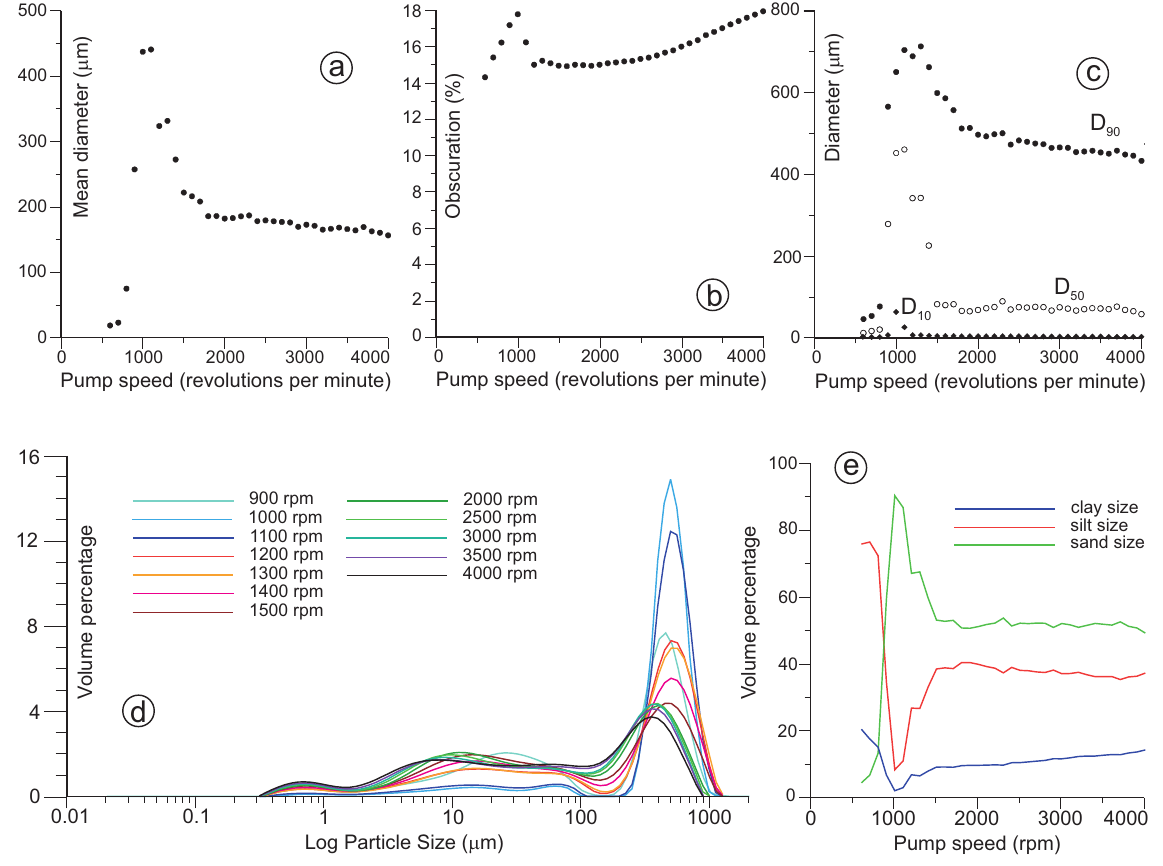
Fig. 4. Results of the pump speed test P 5 performed on sub-sample aliquot CABRE3a by the Hydro 2000 MU dispersion unit. (a) Mean diameter value evolution with increasing the pump speed from 600 up to 4000rpm. (b) Laser obscuration value progression during the same test. (c) Progression of D 10 , D 50 , and D 90 percentiles during the same test. (d) Granulometric curves obtained by averaging data from the corresponding 10 measurement runs during representative pump speed steps. (e) Distribution of clay, silt, and sand size fractions during the